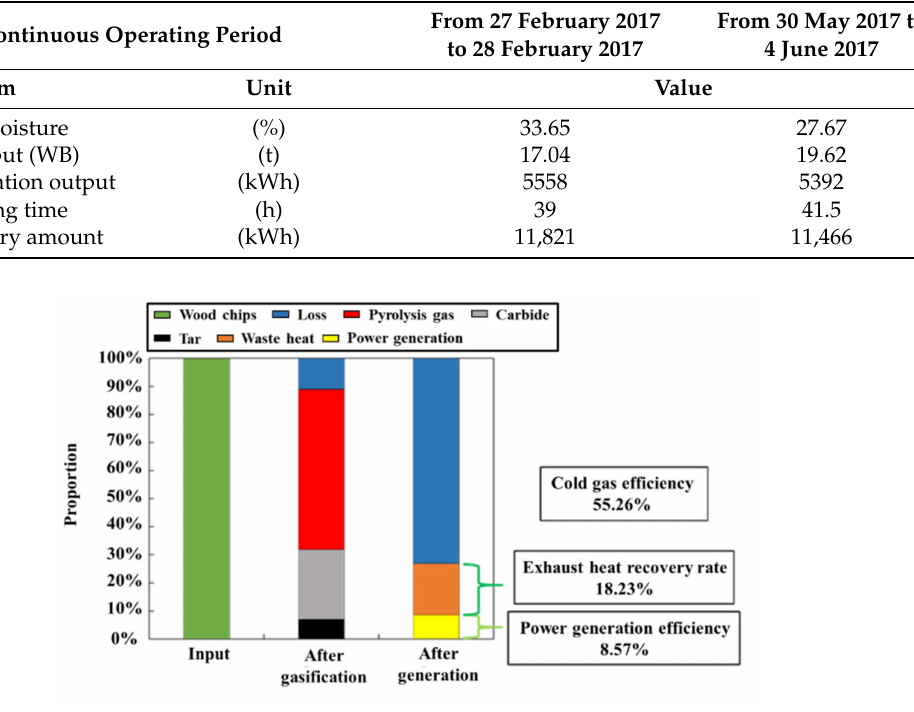
Table 2. Calculation condition of thermal substance. Reprint with permission; JSME, 2020 [19].